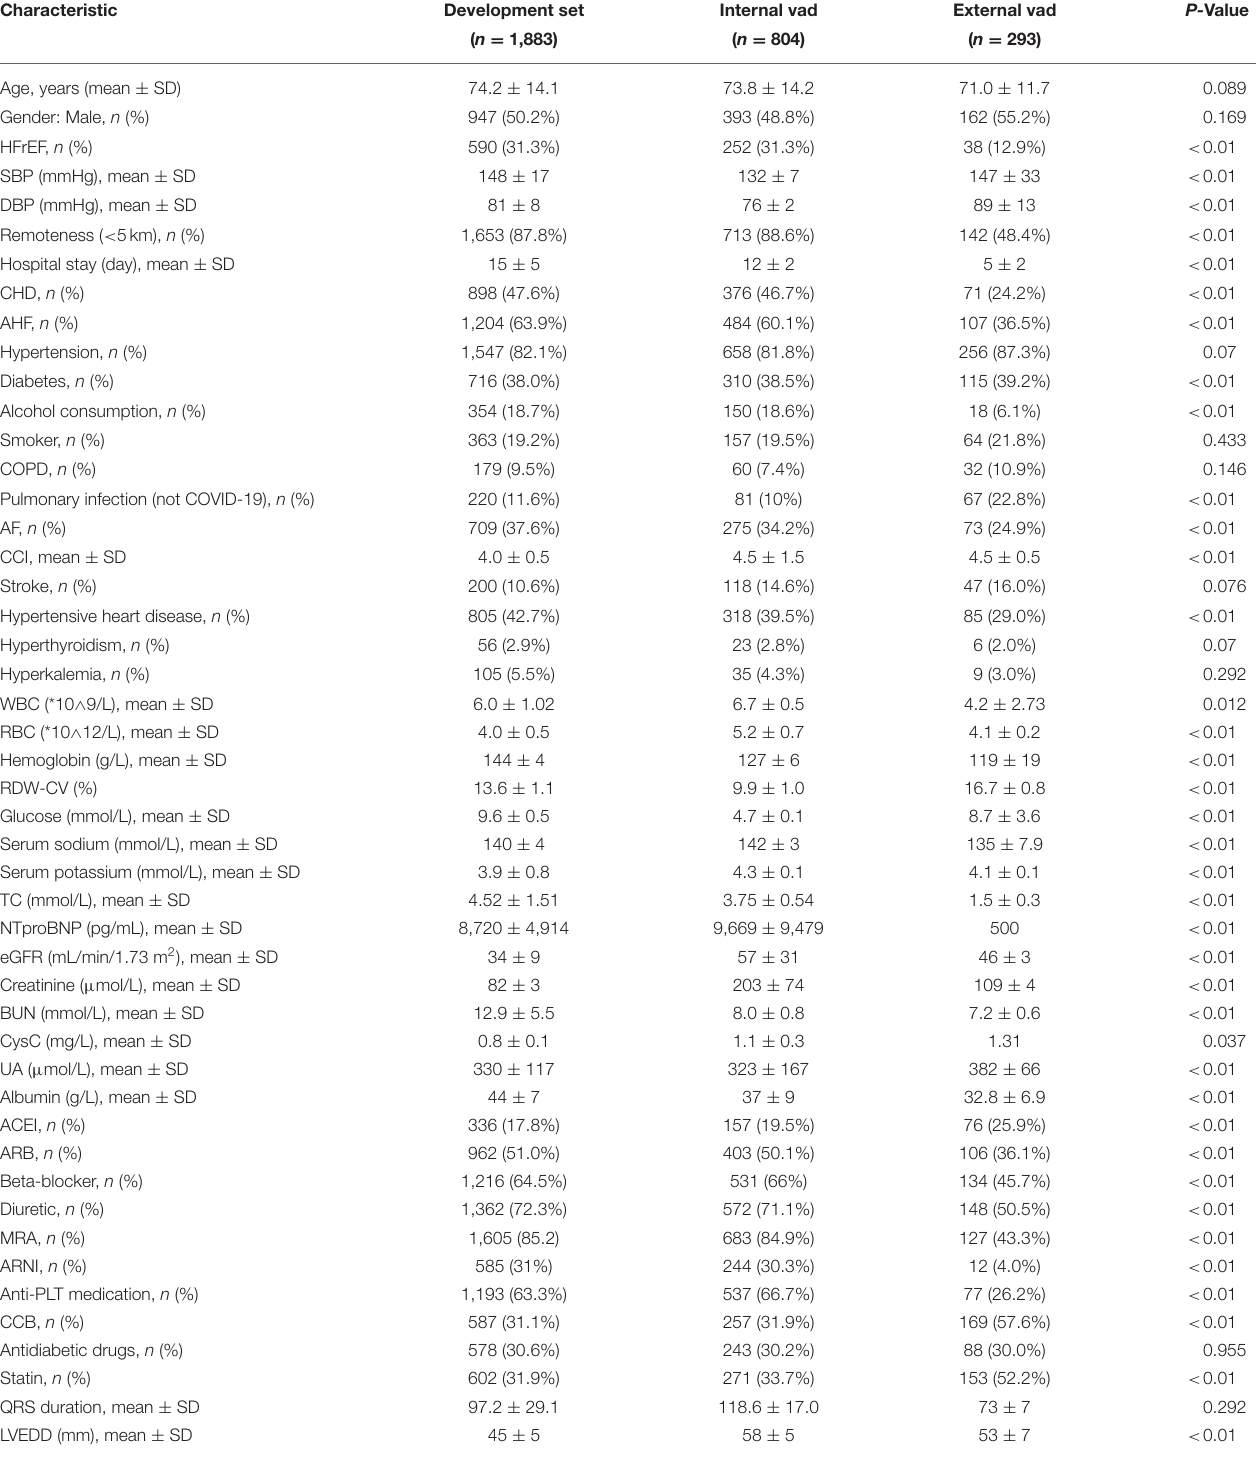
TABLE 1 | Baseline characteristics of the enrolled patients with CHF.